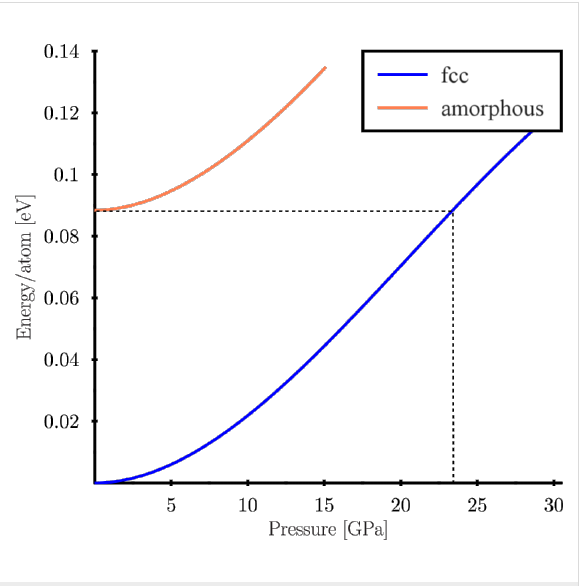
An amorphous region is observed at the orifice throughout the whole simulation, and dislocations carry the plasticity only further inside the particle (see Supporting Information File 2).